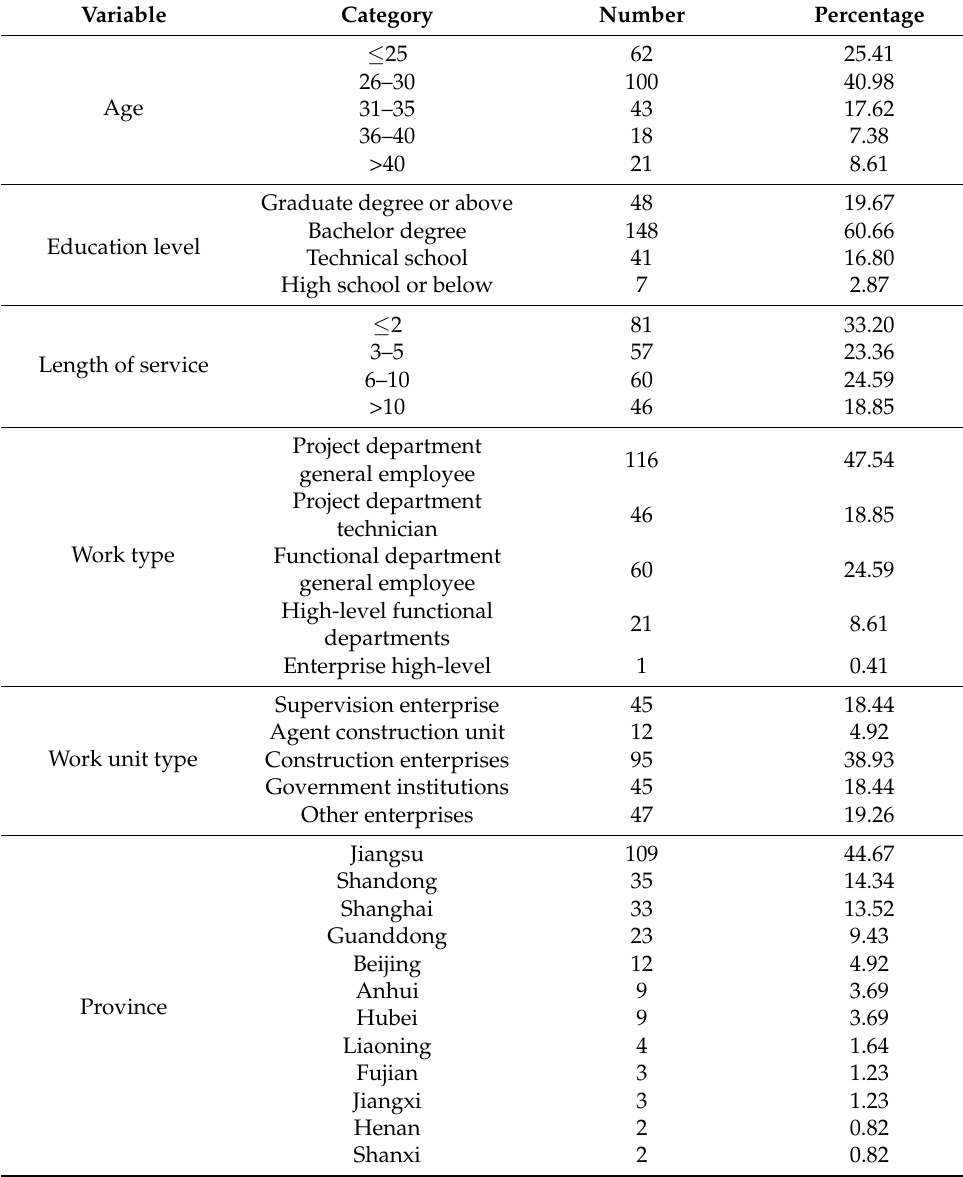
Table 2. Sample demographic